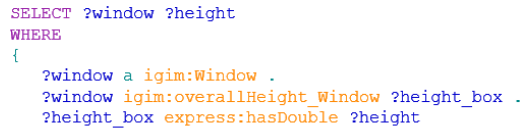
Figure 15: (S R /S T ).G R - Graph-Model Relationships occupancy